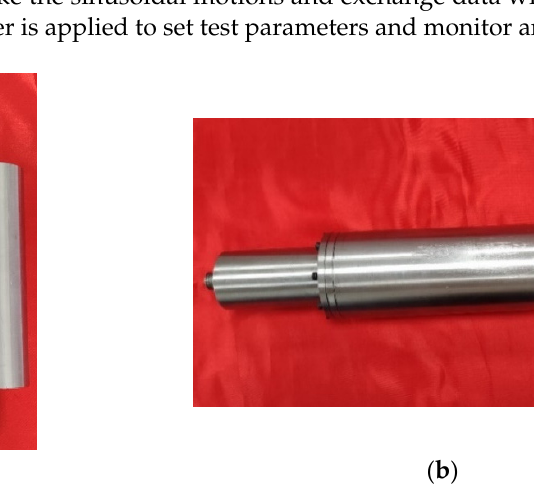
( b ) Figure 13. Comparison of simulation with the initial and optimal MR damper. ( a ) Damping force; ( b ) dynamic range. 5. Test performance of the Optimal MR Damper 5.1. Test Rig Setup